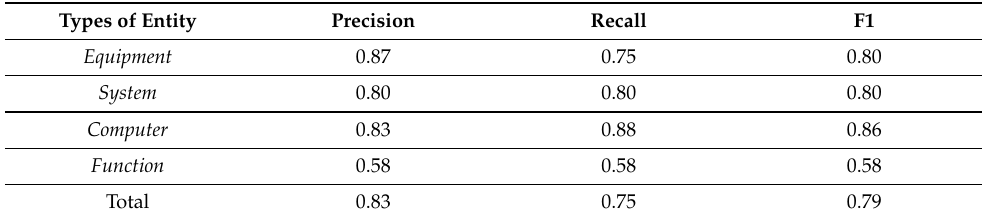
Table 3. The results of concatenating embeddings from part of speech: total _ embedding i = [ WORD ] . i ; POS i